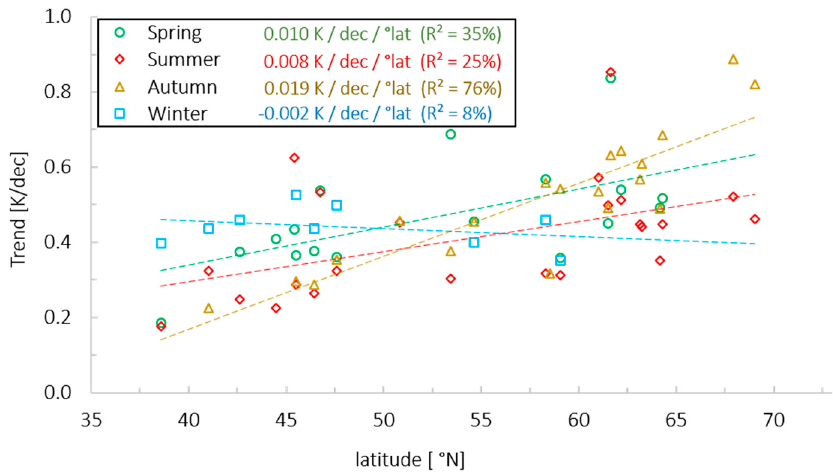
Figure 11. South–North gradient of seasonal trends from European lakes. The dashed lines are simple linear models derived with least square regression of the data points. The reservoirs lakes are excluded from the graph.